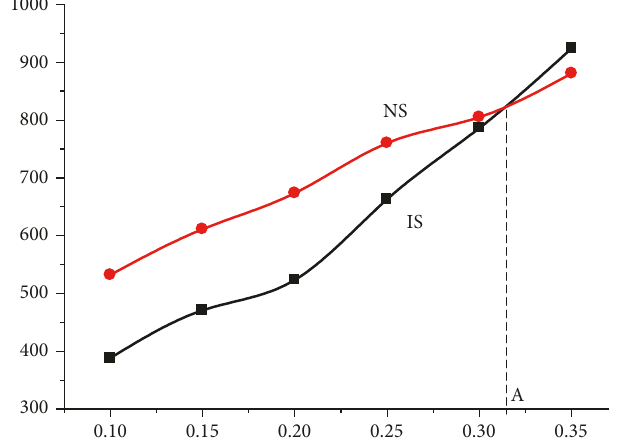
Figure 7: Yield uncertainty versus the retailer’s costs under two